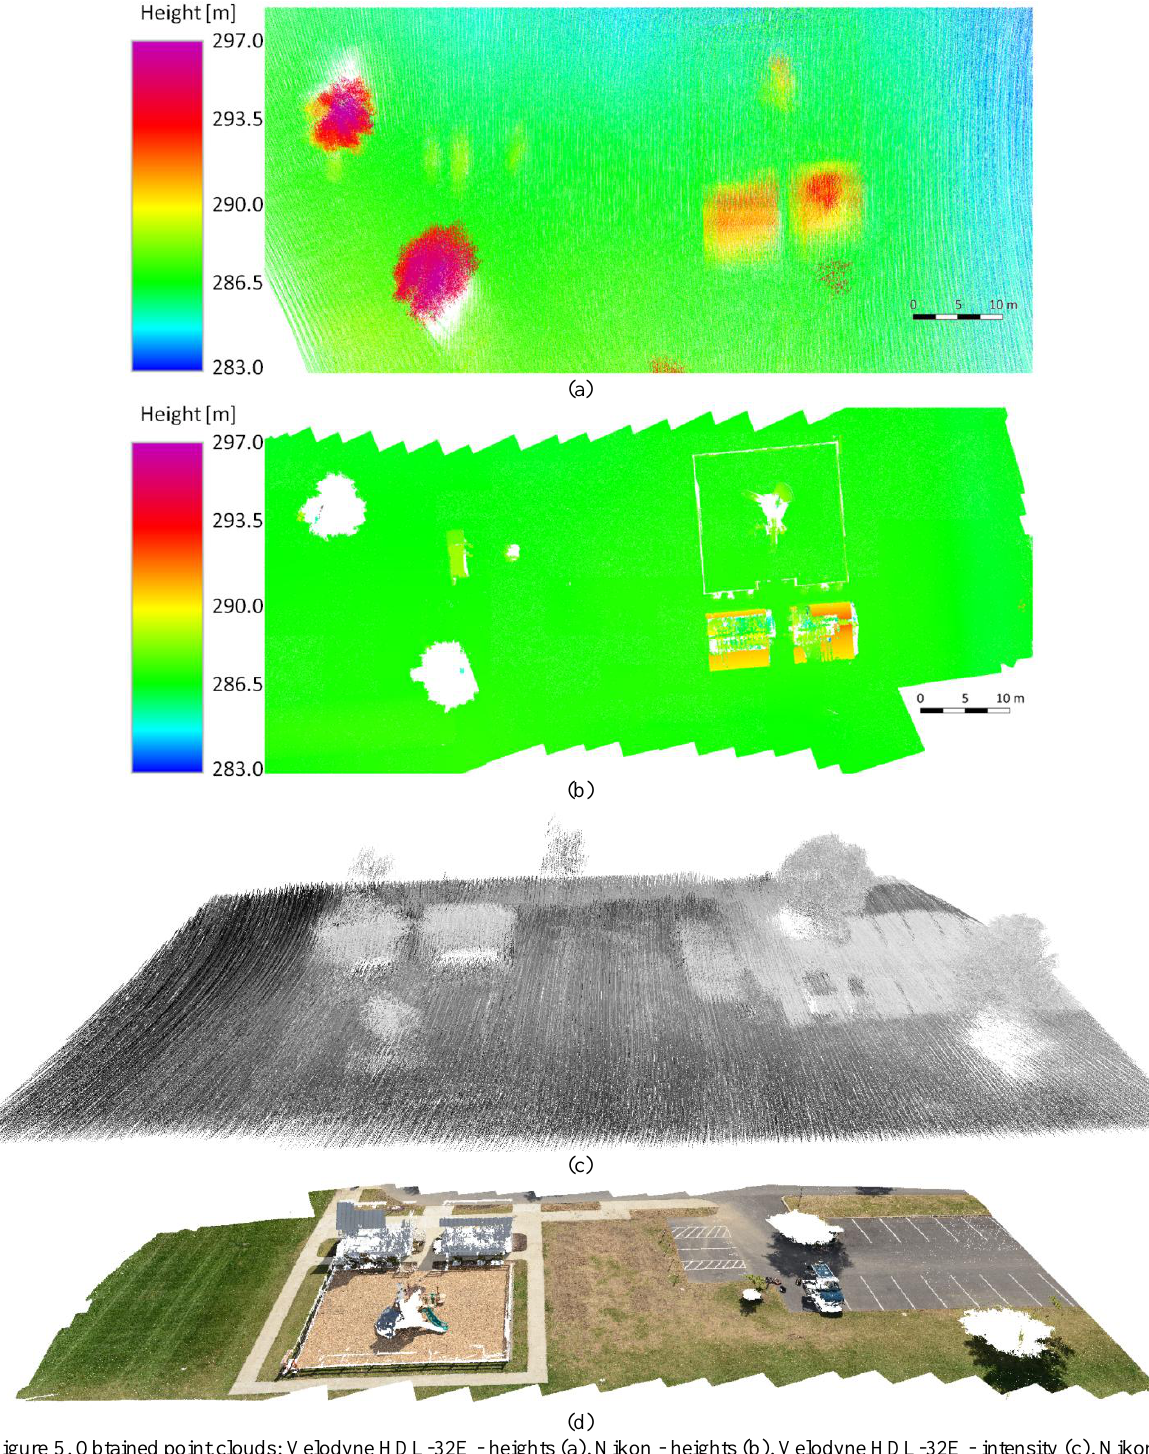
Figure 5. Obtained point clouds: Velodyne HDL-32E - heights (a), Nikon - heights (b), Velodyne HDL-32E - intensity (c), Nikon - RGB